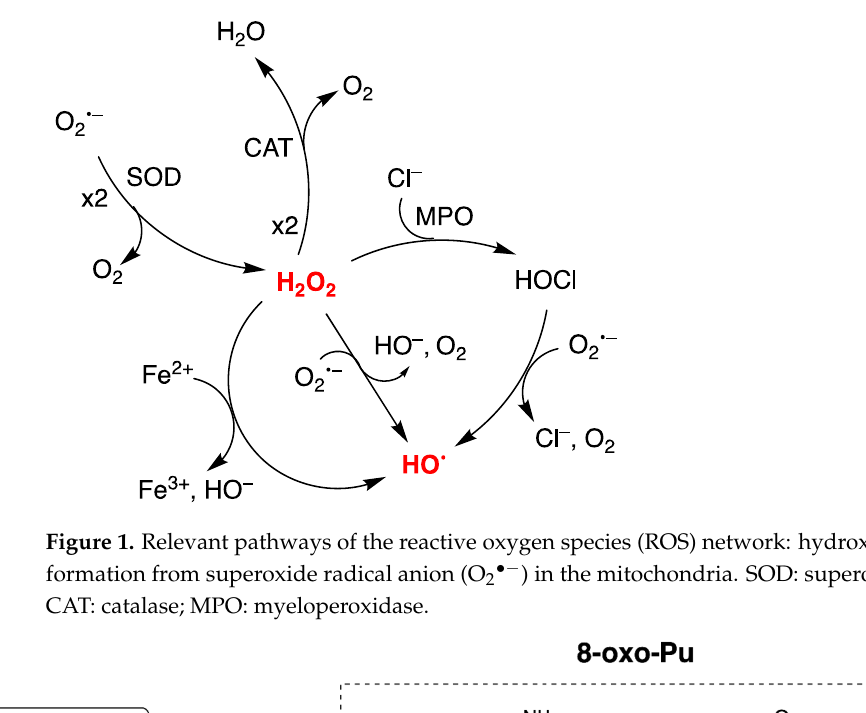
Figure 1. Relevant pathways of the reactive oxygen species (ROS) network: hydroxyl radical (HO • ) formation from superoxide radical anion (O 2 •− ) in the mitochondria. SOD: superoxide dismutase; CAT: catalase; MPO: myeloperoxidase.